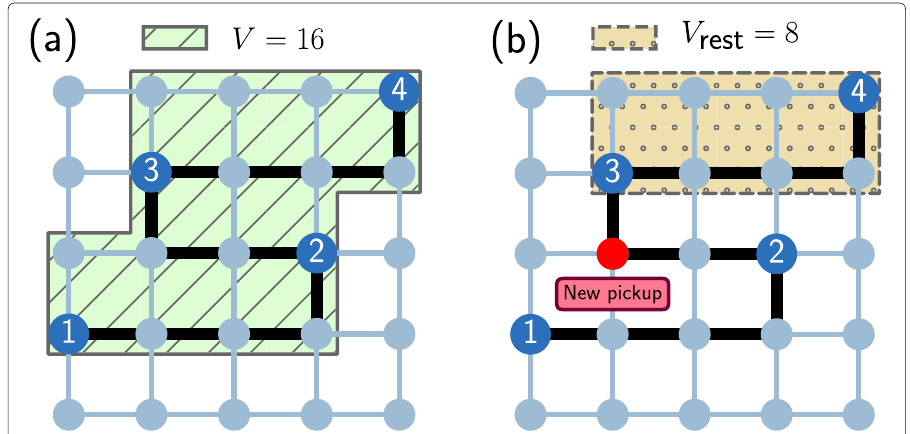
Fig. 7 Illustration of V and V rest . a A stoplist of length 4 in a 5 × 5 square grid. The volume is 16. b A new pickup is inserted before the 3rd stop. V rest is